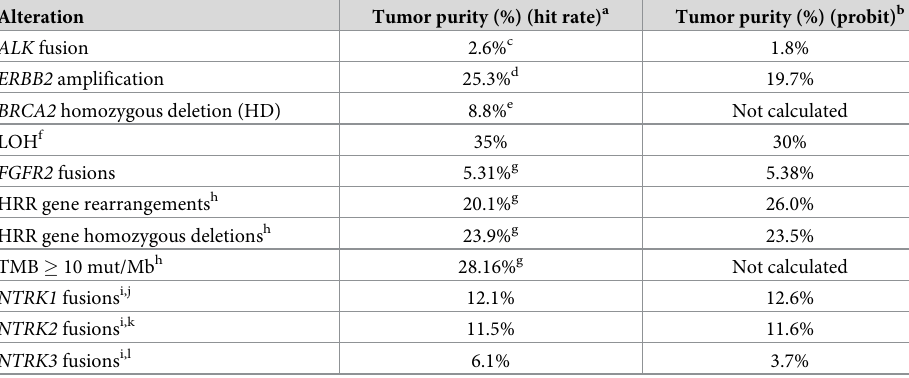
Table 8. Sample validation for F1CDx companion diagnostic claims.